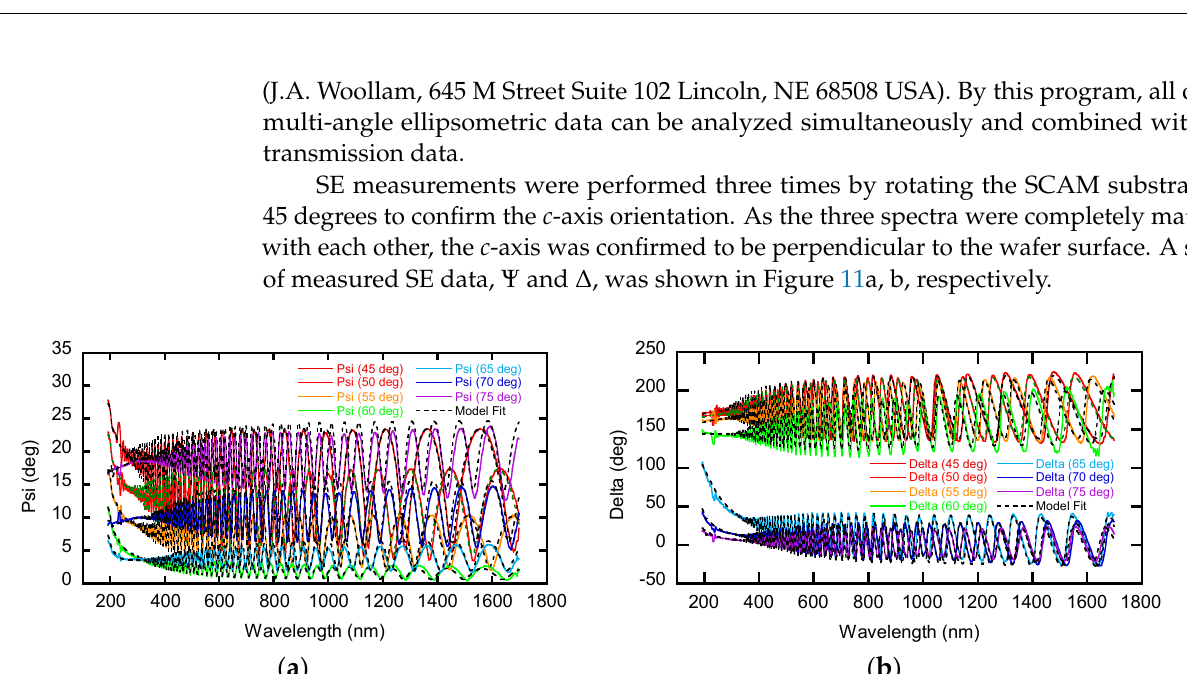
SE data were analyzed through the combination with the transmission data mentioned